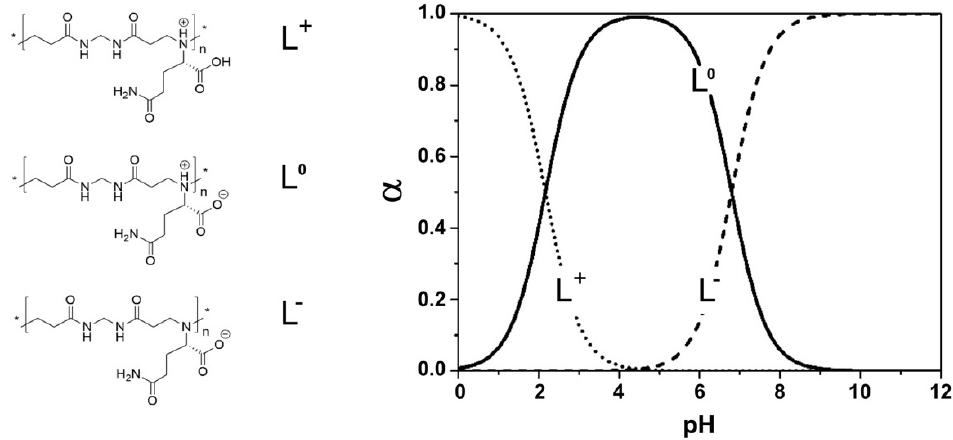
Figure 1. Ionization states and speciation diagram of M- L -Gln.